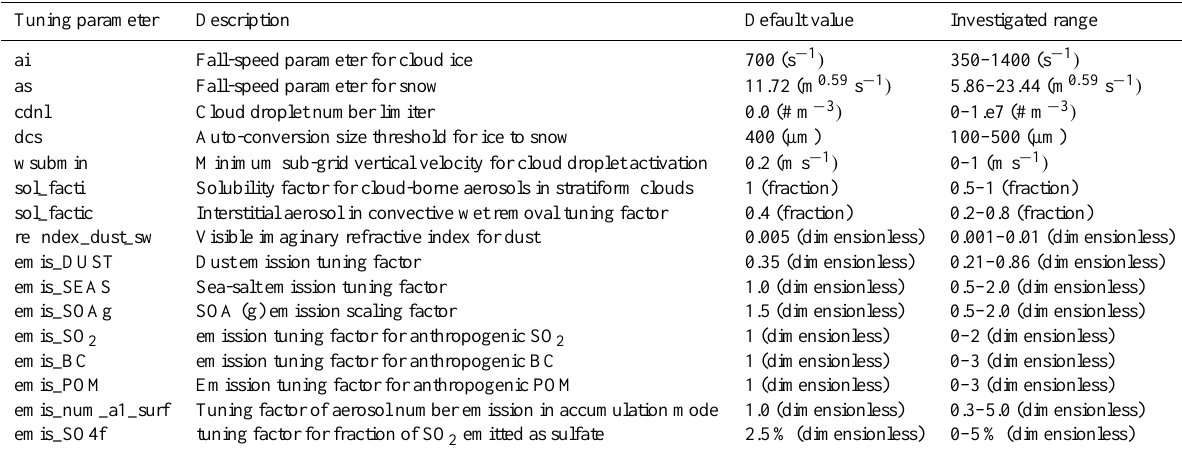
Table 1. CAM5 cloud microphysics and aerosol parameters of interest. The top eight parameters are defined as internal parameters and the rest are defined as external